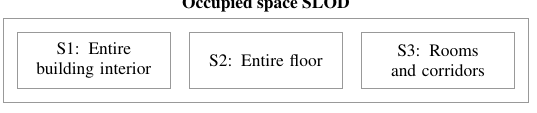
Figure 8. Levels of occupied space SLOD